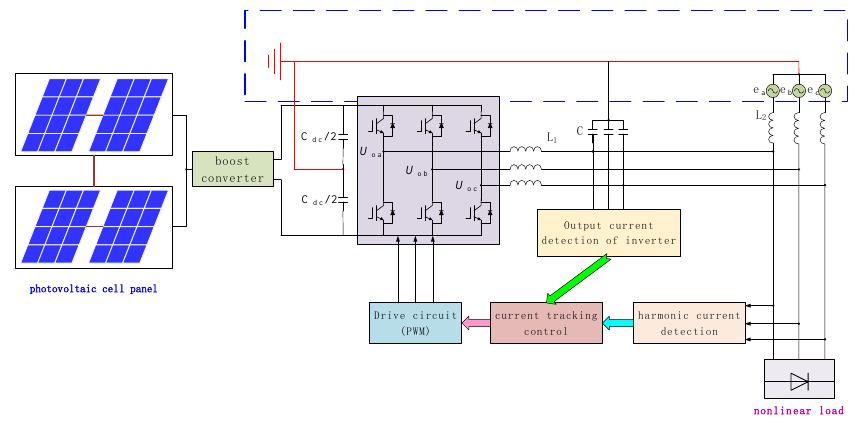
Figure 10. Improved two-stage system block diagram.